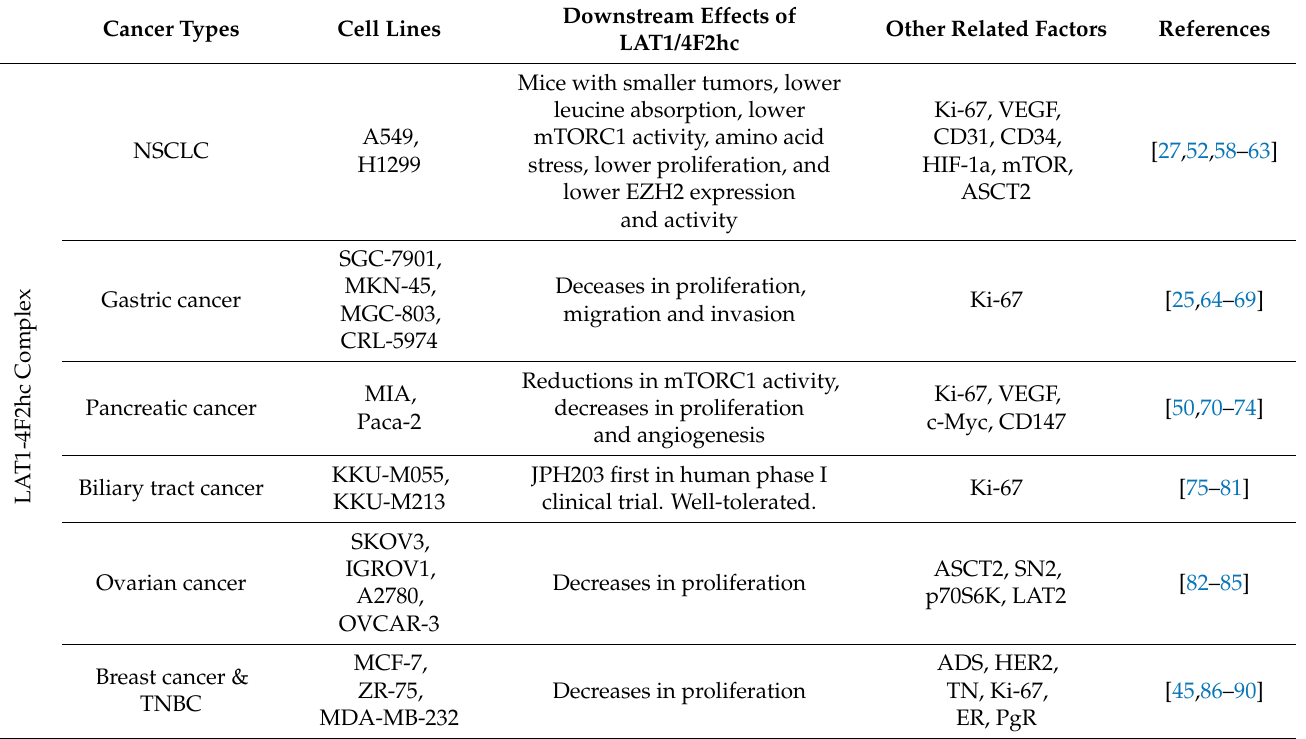
Table 1. LAT1-4F2hc and Common